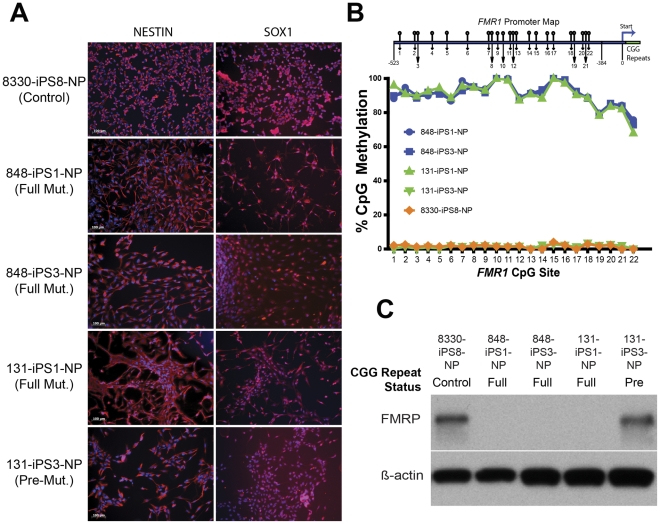
Isolation and Characterization of Expandable Neuronal Progenitor Cells from iPSC Clones.(A) Immunocytochemical analysis of NESTIN and SOX1 (red, nuclei DNA staining overlaid in blue) expression in expanded neural cells from indicated iPSC lines expanded in the presence of mitogens EGF and bFGF. (B) Bisulphite pyrosequencing analysis of the FMR1 promoter reported as relative methylation level at indicated CpG positions in indicated neural differentiated iPSC lines (FMR1 promoter CpG site schematic not to scale). (C) Western blot analysis of FMRP protein levels in indicated neural differentiated iPSC lines, β-actin is shown as a loading control.